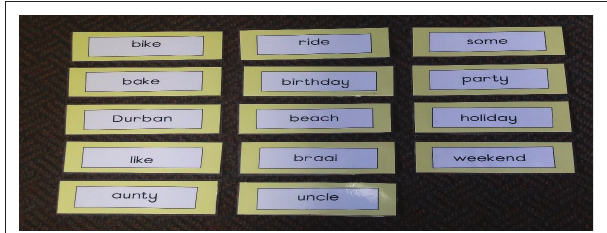
FIGURE 5: Commonly misspelt words by English Second Language